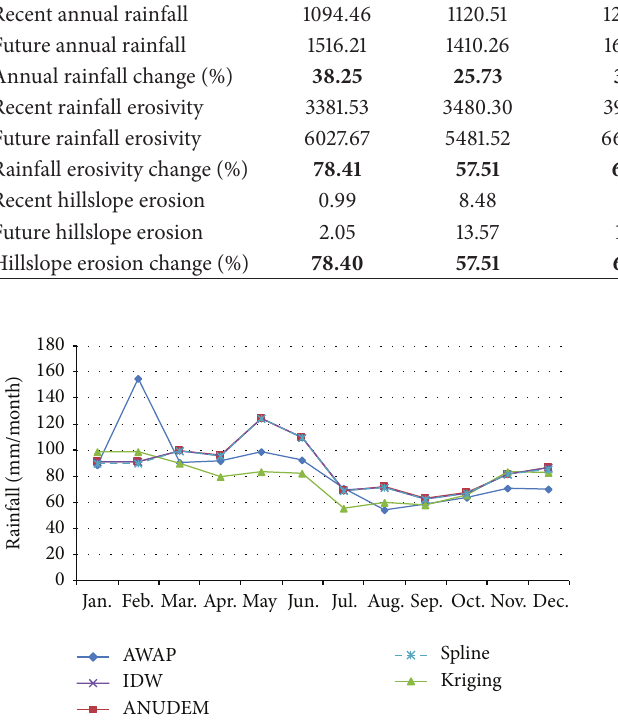
Figure 6: Monthly rainfall and variation between interpolation and AWAP.